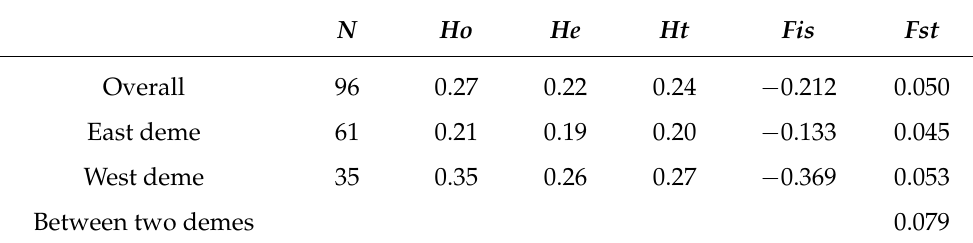
Table 2. Genetic diversity of prairie cordgrass populations. Two demes were categorized-based fastStructure and DAPC of 9315 SNPs data. Heterozygosities were calculated using ‘hierfstat’ R package [51]; Fixation index was calculated using ‘hierfstat’ R package according to Weir & Cockerham [52].